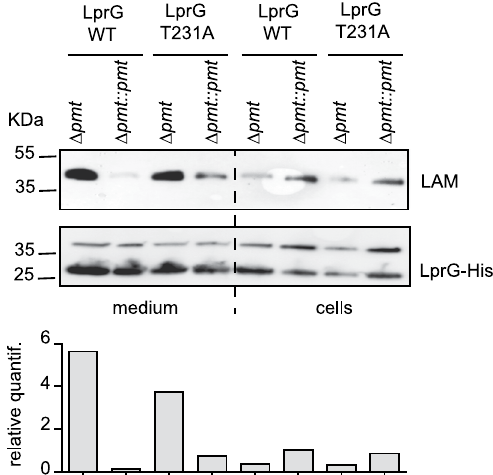
Figure 4. Impact of LprG O -mannosylation on the release of the LprG/LAM complex in M . smegmatis . Similar amounts of LprG-His or LprG-His T231A purified from either culture medium or bacterial cells were separated by SDS-PAGE, transferred onto membranes and revealed using anti-LAM or anti-His antibodies. The genetic backgrounds in which the protein was produced are indicated. The upper band revealed by the anti-His antibody is a non-specific cross-reacting protein. The signal intensity for LAM was quantified and plotted in the graph below the Western blot image. This blot is representative of three independent